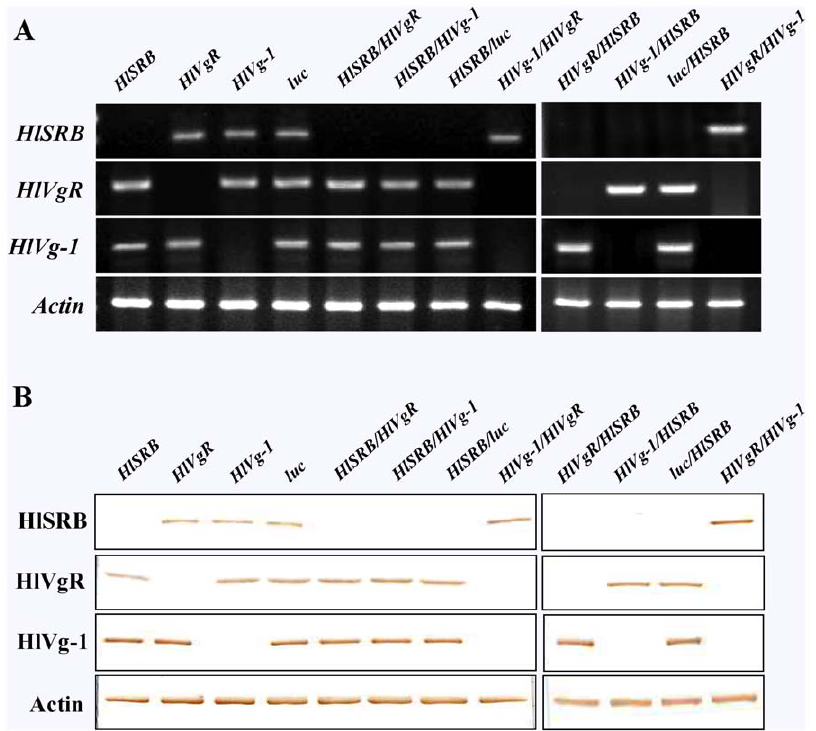
Figure 2. Silencing of HlSRB, HlVgR, and HlVg-1 genes and proteins in the whole body of H.longicornis. Individually or in combination of HlSRB , HlVgR , HlVg-1 , and luc dsRNA(s) were injected into H. longicornis adult ticks. The injected ticks were left for 12 hours at 25 u C and infested on the rabbits for four days and then ticks samples were collected for RNA extraction and the preparation of ticks protein lysates in each group. The name of each dsRNA group is indicated above. RT-PCR analysis (A). RT-PCR analysis was performed as shown in Fig. 1. (A). Western blot analysis (B). Tick lysates were subjected to SDS-PAGE under reducing conditions and transferred to a PVDF membrane. The membrane was probed with mouse anti-rHlSRB, anti- rHlVgR, or anti-rHlVg-1 sera; mouse anti-actin serum was used as a control. The name of each dsRNA group is the same as that used in Fig.